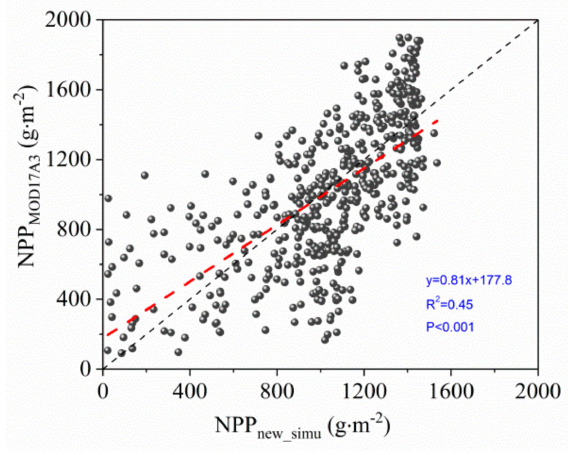
Figure 7. Comparison of estimated NPP and MOD17A3 NPP (average values from 2000 to 2017).